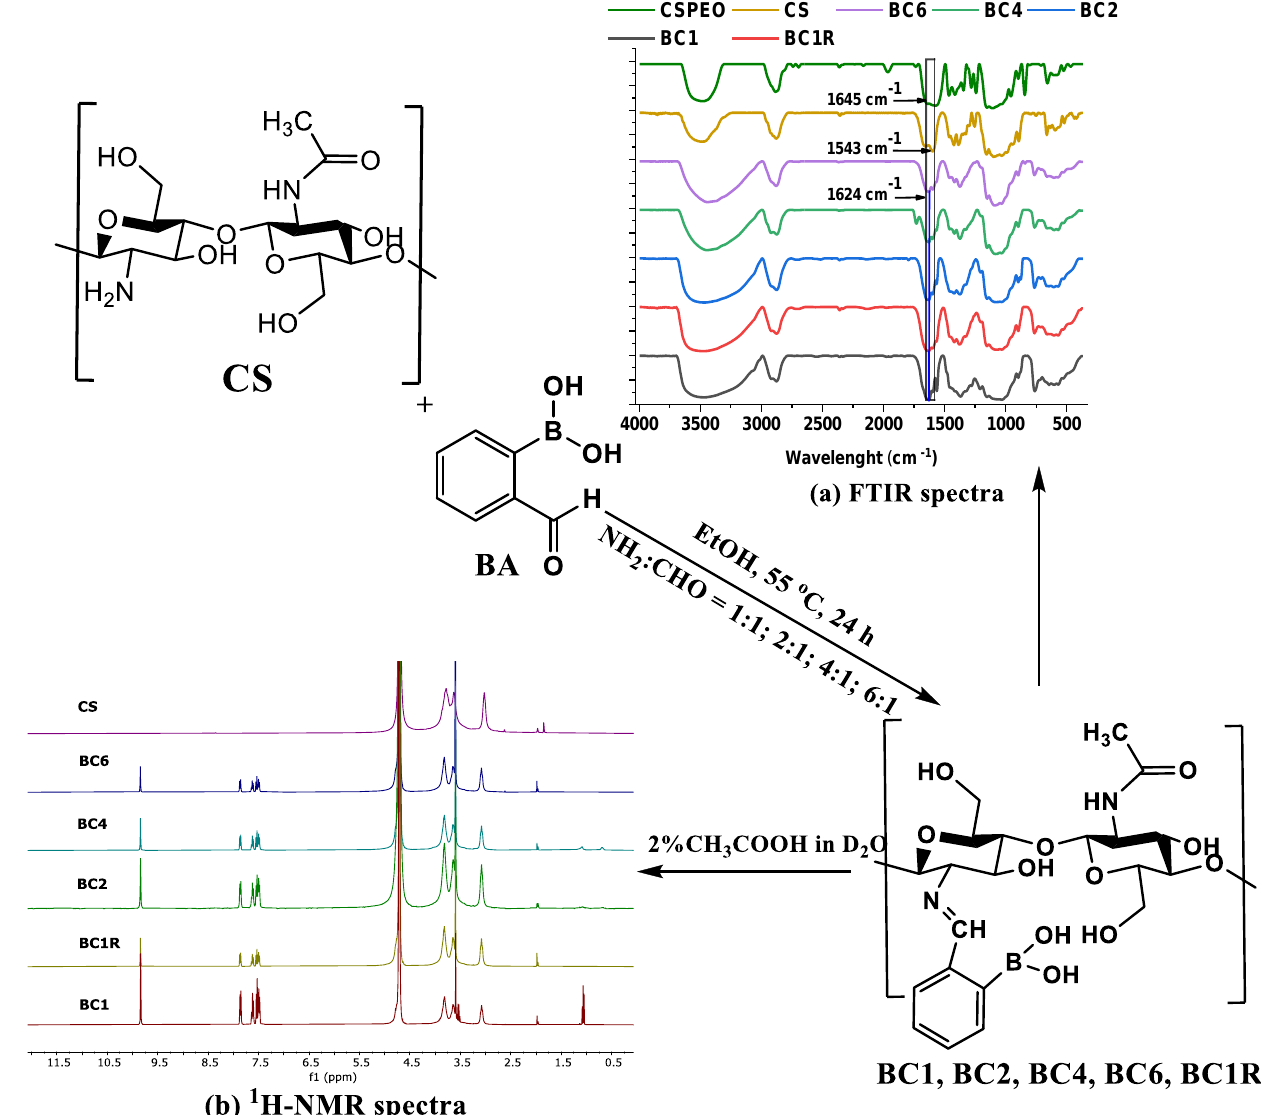
Figure 1. Synthesis of imino-chitosan fibers, and their FTIR ( a ) and 1 H-NMR ( b ) spectra compared to chitosan precursors.